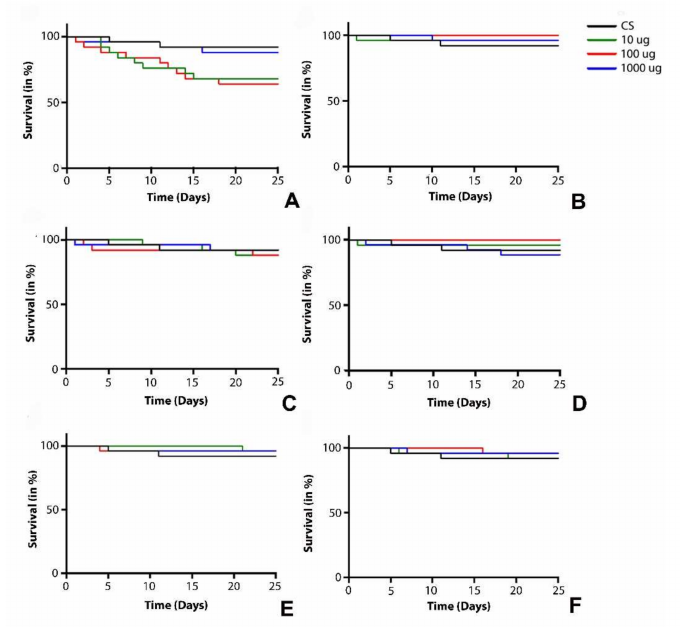
Figure 5. Survival assay curve of female flies treated with mesoporous carbon nanoparticles ( A ) CNS500, ( B ) CNS600, ( C ) CNS700, ( D ) CNS800, ( E ) CNS900, and ( F ) CNS1000 at 10, 100, and 1000 µ g/mL doses, respectively. Here, the black curve represents the survival rate of control flies. The blue, red, and green curves represent the survival rates of female flies at 10, 100, and 1000 µ g/mL doses, respectively.